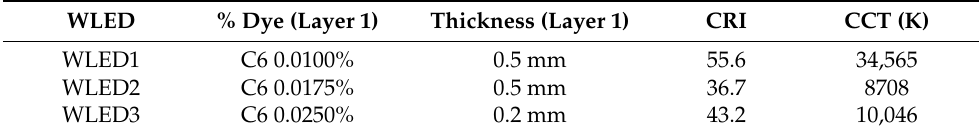
Table 2. A summary of WLEDs devices (4 to 21) along with their optical properties. WLED